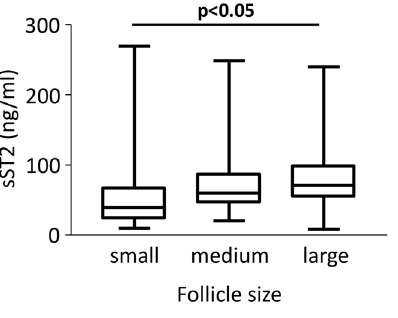
Figure 2. Higher levels of sST2 are expressed in larger follicles. sST2 levels in individual follicles, classified as small (n=16), medium (n=35) or large (n=80), were determined by ELISA. Means 6 S.E.M.